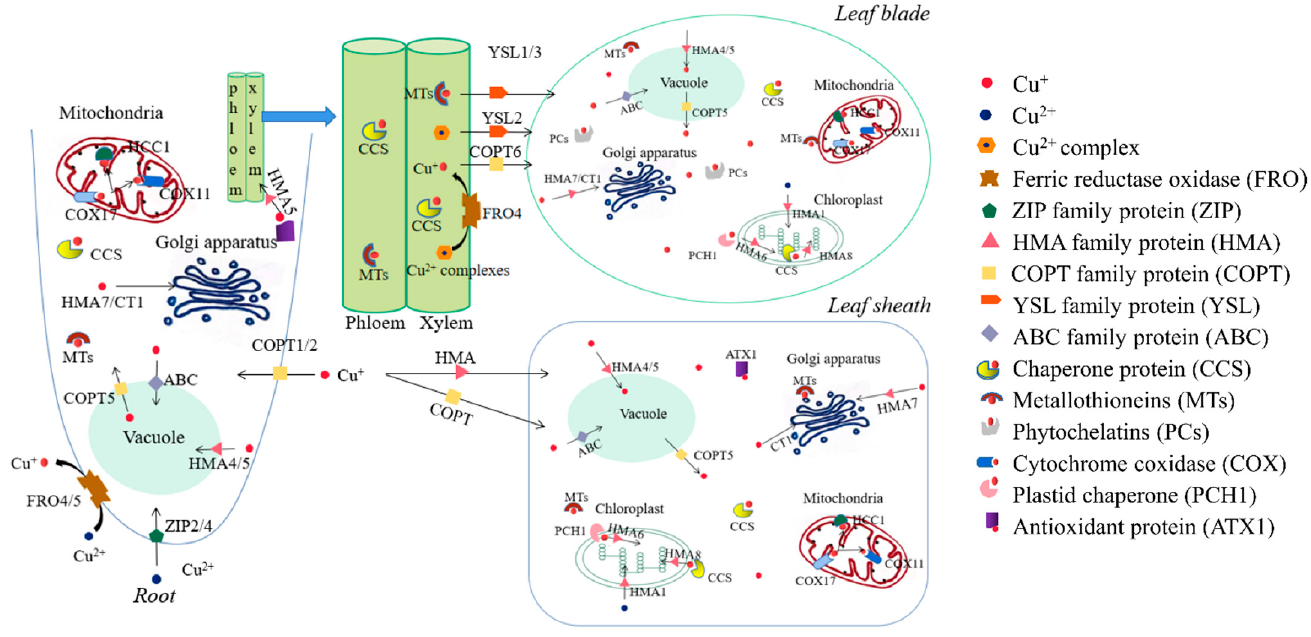
Figure 1. Copper transport process in plants. FRO, Ferric reductase oxidase; ZIP, Zn-regulated transporter; HMA, Heavy metal ATPase; COPT, Copper transporter protein; YSL, Yellow stripe-like protein; ABC, ATP-binding cassette transporter; CCS, Cu chaperone; MTs, Metallothioneins; PCs, Phytochelatins; COX, Cytochrome coxidase; PCH, Plastid chaperone; ATX1, Antioxidant protein; CT, MFS-type Cu transporter.